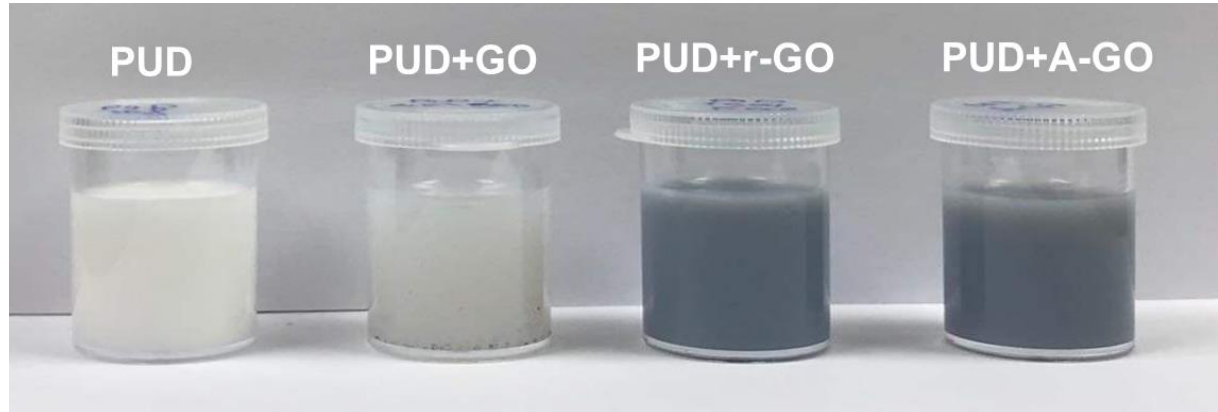
Figure 2. Appearance of the PUDs without and with 0.04 wt.% GO derivative, one month after synthesis.